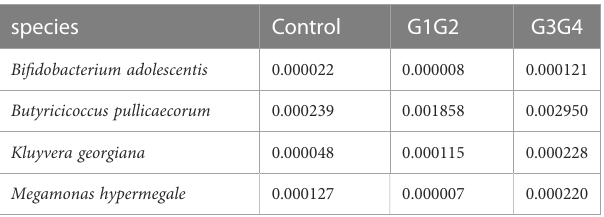
TABLE 6 Relative abundance of differential strains enriched in the control group.